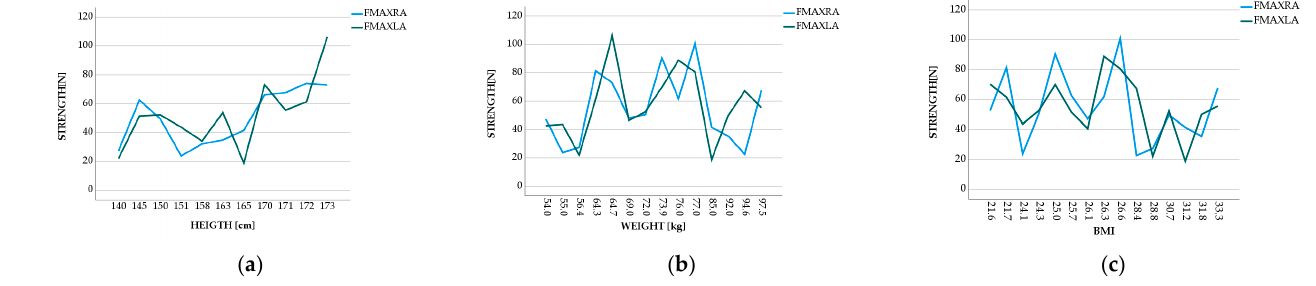
Figure 5. Visualization of graph: ( a ) height–strength; ( b ) weight–strength; ( c ) BMI–strength.